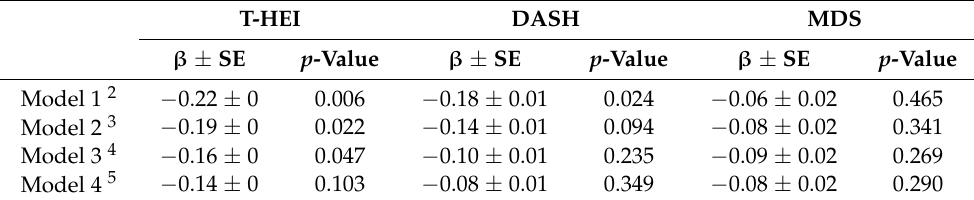
Table 4. β ± SE of frailty for 1-SD increase in each dietary quality score 1 .